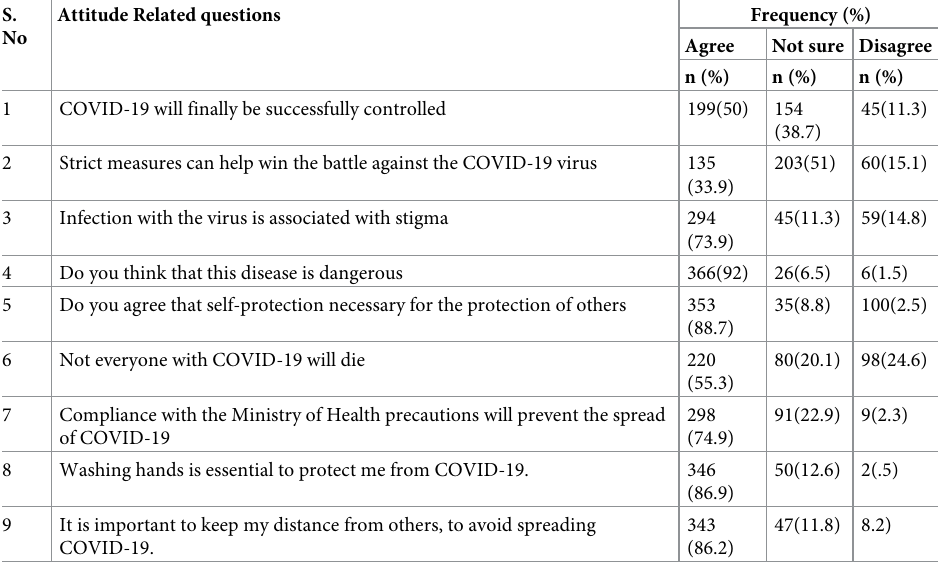
Table 4. Attitude towards COVID-19 among outpatient service visitors at Debre Markos comprehensive special- ized hospital, Amhara regional state, Ethiopia, 2020. S.